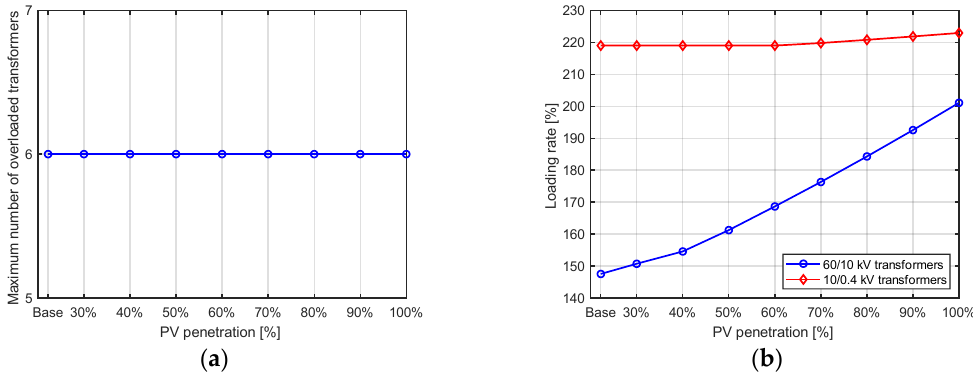
Figure 6. The worst overload situations of transformers at different penetration levels (with PF ( P )): ( a ) Yearly maximum number of overloaded transformers; ( b ) Yearly maximum transformer loading rate.